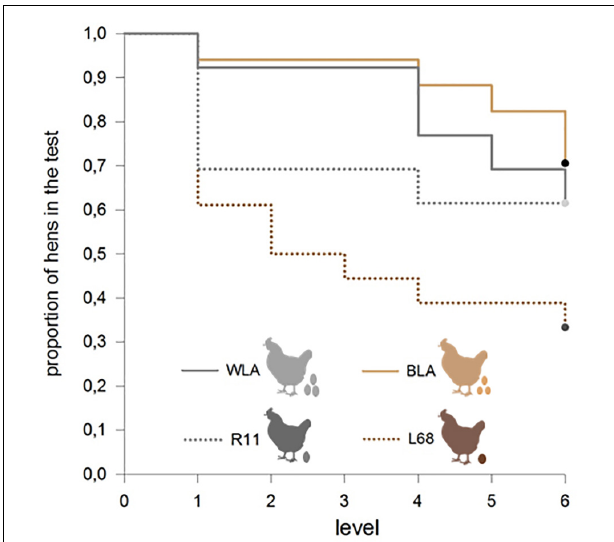
FIGURE 2 | Proportion of hens that successfully pass the learning tasks of each level. A greater proportion of high productive hens, WLA and BLA, achieved the learning criteria at the screen training and learning level, compared to moderate productive hens, R11 and L68 (Chi 2 3 = 8.25, p = 0.041).